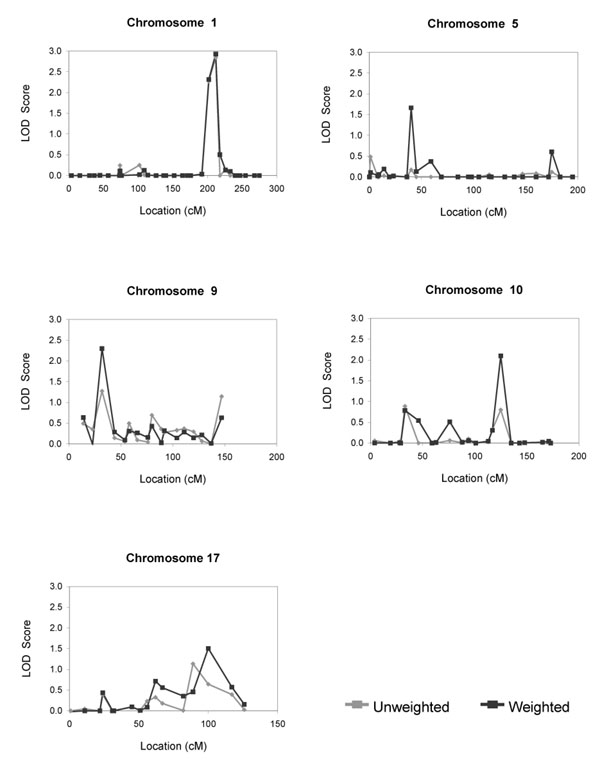
LOD scores on four chromosomes based on genetic analyses of intercepts that either do (weighted) or do not (unweighted) incorporate first-stage standard errors